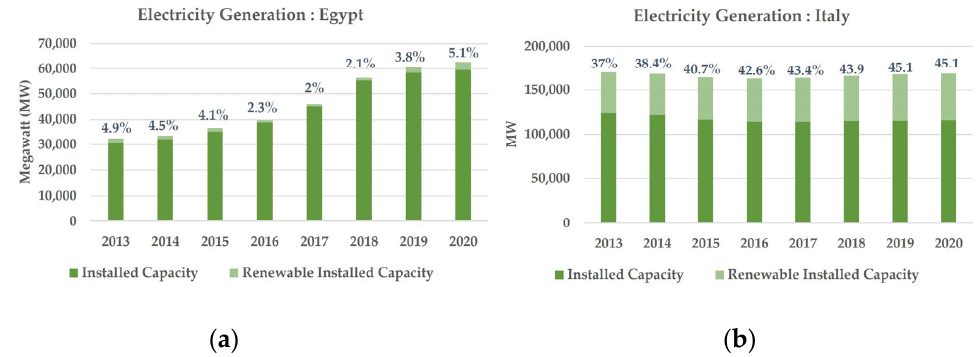
Figure 4. Installed capacity, renewable installed capacity of electricity generation, and renewable percentage; ( a ) in Egypt, based on the Egyptian electricity holding company annual reports [83]. The figure shows that the generation was doubled within six years, and the renewable percentage (from wind and solar) reached 5.1%, whereas the aim is 42% in 2035; ( b ) in Italy [84], the growth targets for 2030 for the renewables share in the electricity sector is 55%. The figure shows the generation is steady compared to Egypt.